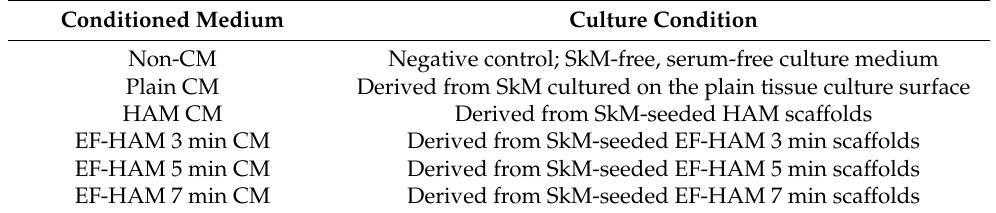
Table 1. Types of Conditioned Media Collected for Use in Angiogenesis Functional